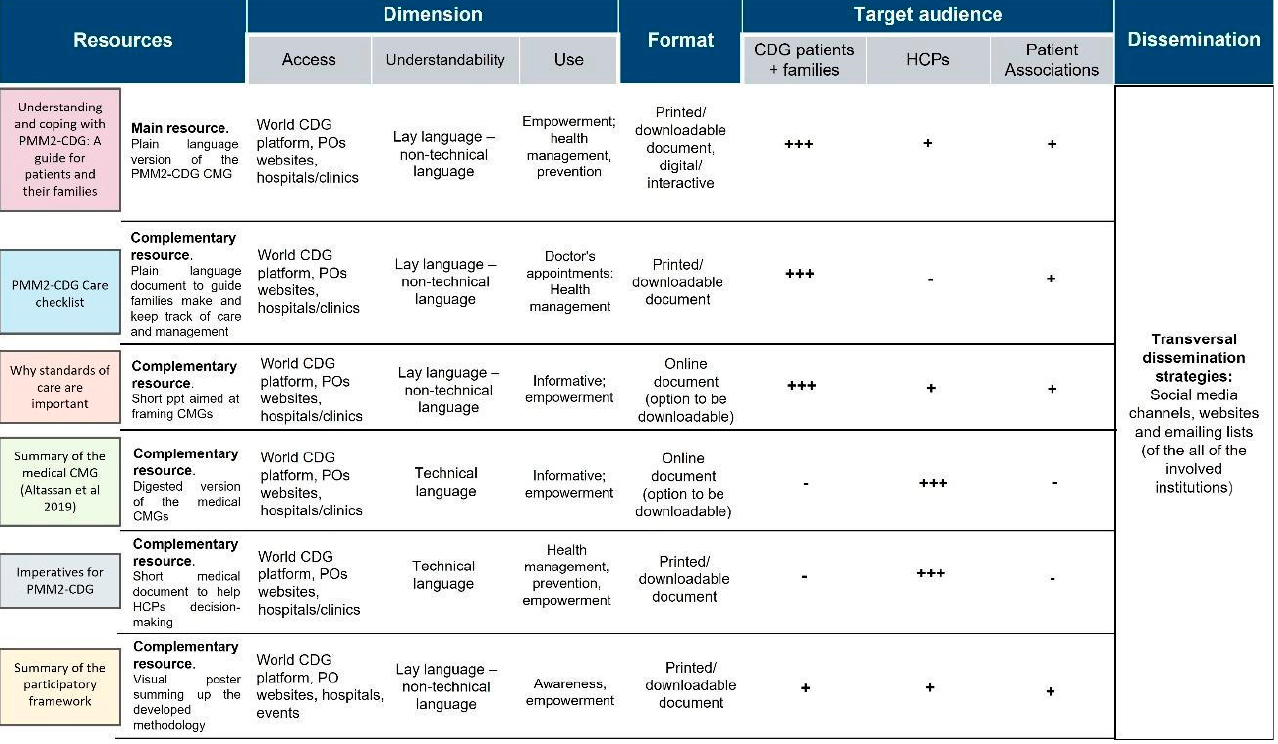
Figure 7. The six CMG-related resources co-created by the CDG family and professional communities. A tripartite category was adopted to identify the target audiences: +++: primary target audience; +: secondary/complementary target audience; -: untargeted audience; legend: HCP—health care professionals; POs—patient organisations.